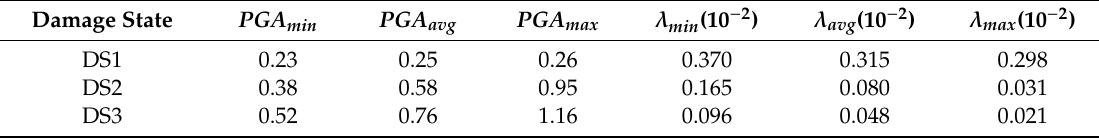
Table 6. Value of PGA-capacity and seismic risk for the considered damage